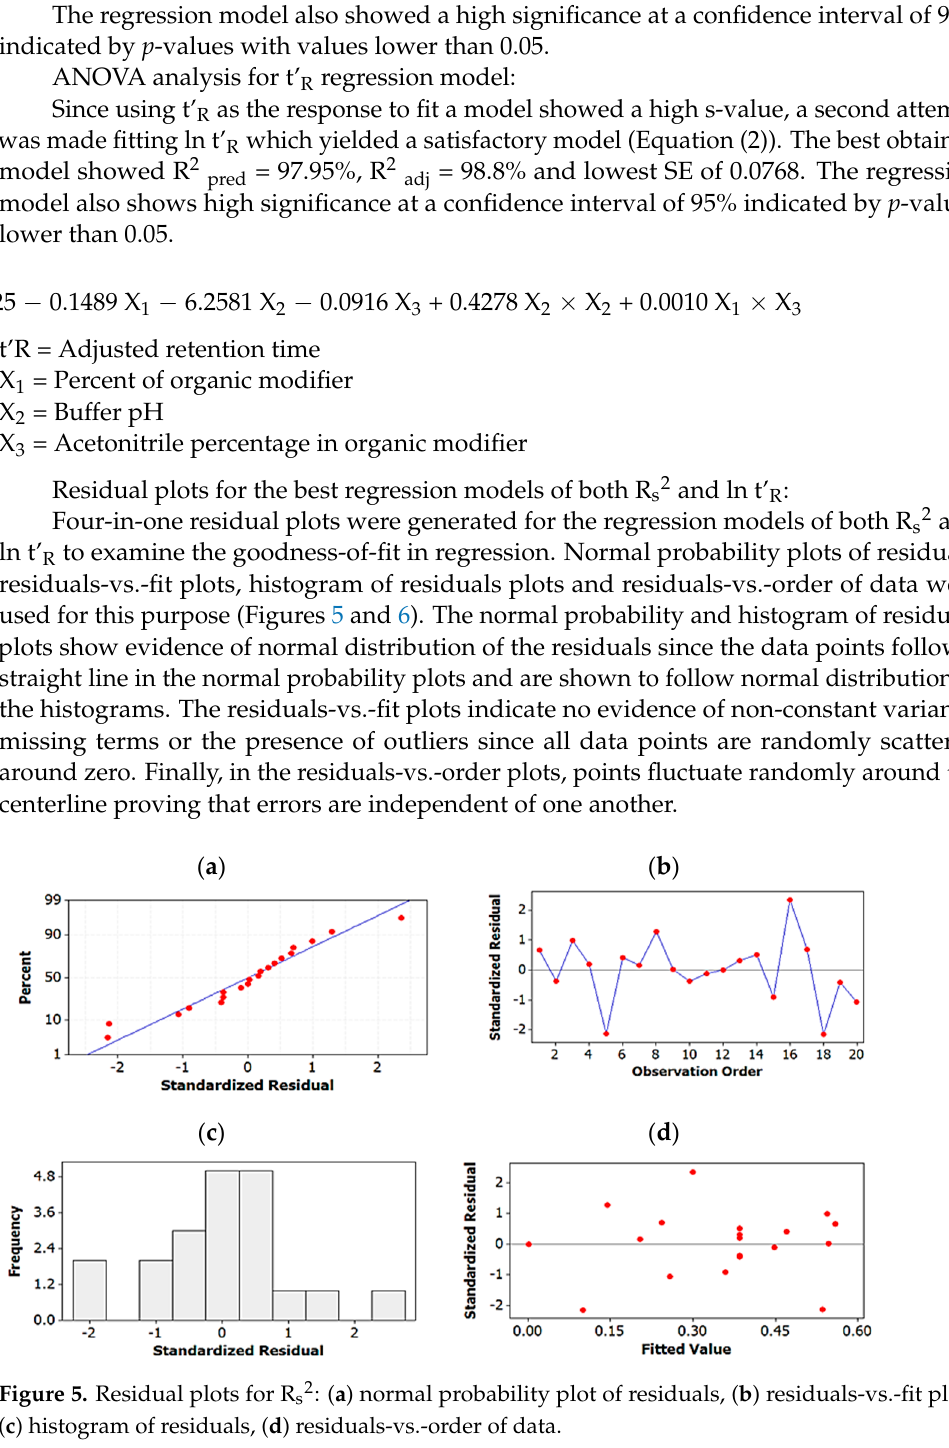
( d ) Figure 6. Residual plots for ln t’ R: ( a ) normal probability plots of residuals, ( b ) residuals-vs.-fit plots, ( c ) histogram of residuals, ( d ) residuals-vs.-order of data. 2.1.4. Testing Model Predictability